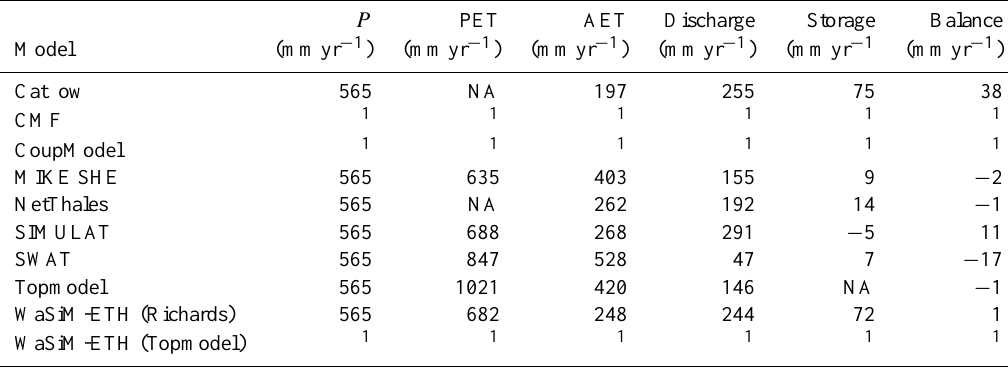
Table 9. Water budget components of the second year (third prediction) (NA: not available). P PET AET